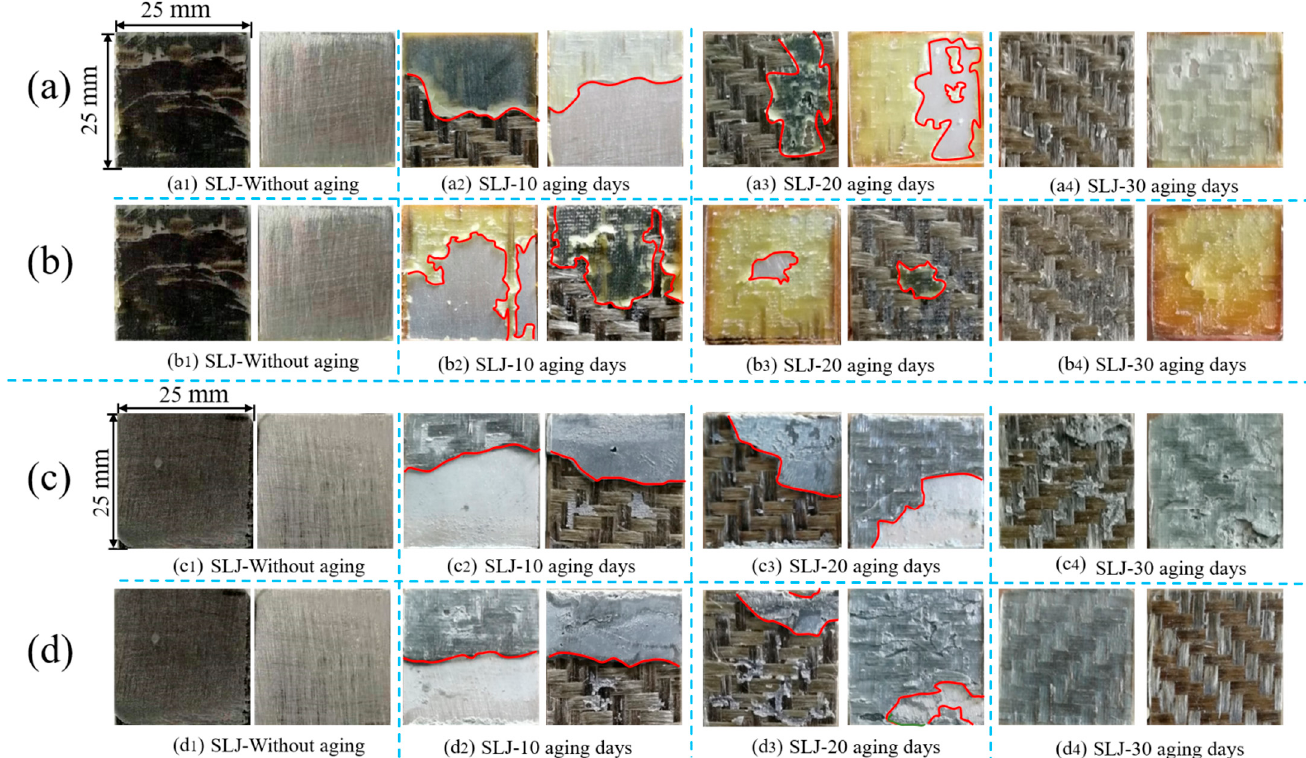
Figure 12. The surface of different adhesive joints in different environments: ( a ) Araldite®2012 joints in 80 °C/95%RH, ( b ) Araldite®2012 joints in 80 °C/pure water, ( c ) Araldite®2014 joints in 80 °C/95%RH, and ( d ) Araldite®2014 joints in 80 °C/pure water.